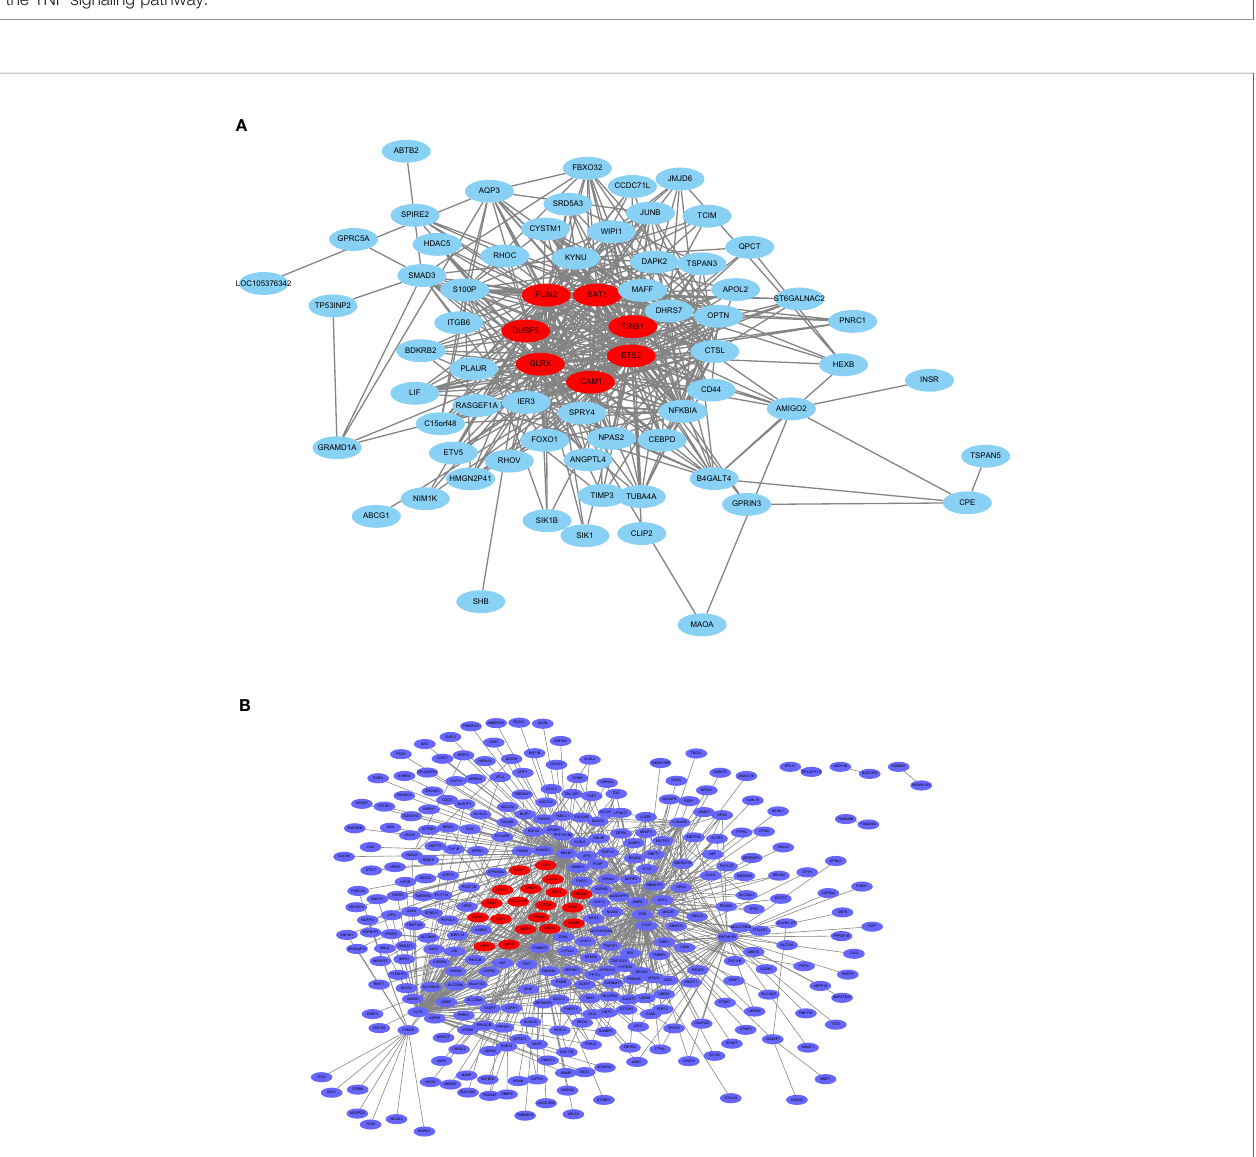
FIGURE 10 | The co-expression network. (A) The co-expression network of the signi fi cant genes in the thistle2 module, including 72 nodes. (B) The co-expression network of the signi fi cant genes in the blue module, including 728 nodes. The hub genes were represented in red color. Cytoscape (v3.8.1) software was downloaded from the website (https://cytoscape.org/) and three models were chosen including “ source node ” , “ target node ” , and “ edge attribute ” with default